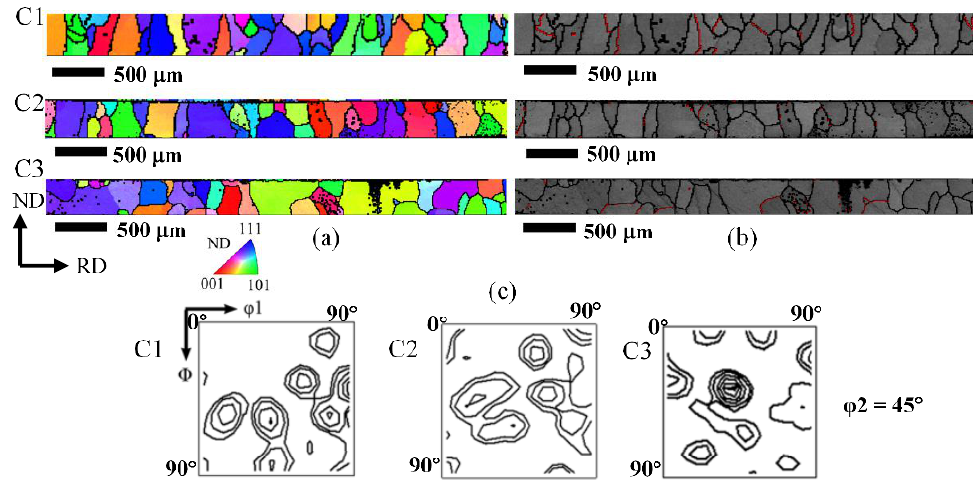
Figure 10. EBSD maps of 2# sheets after final transformation treatment by 1150 °C of three conditions C1 to C3 following cold rolling of columnar grained samples to 0.35 mm. ( a ) IPF-ND maps ( b ) band contrast maps with boundary characters (red lines: Σ3); ( c ) ODFs at ϕ 2 = 45° section.